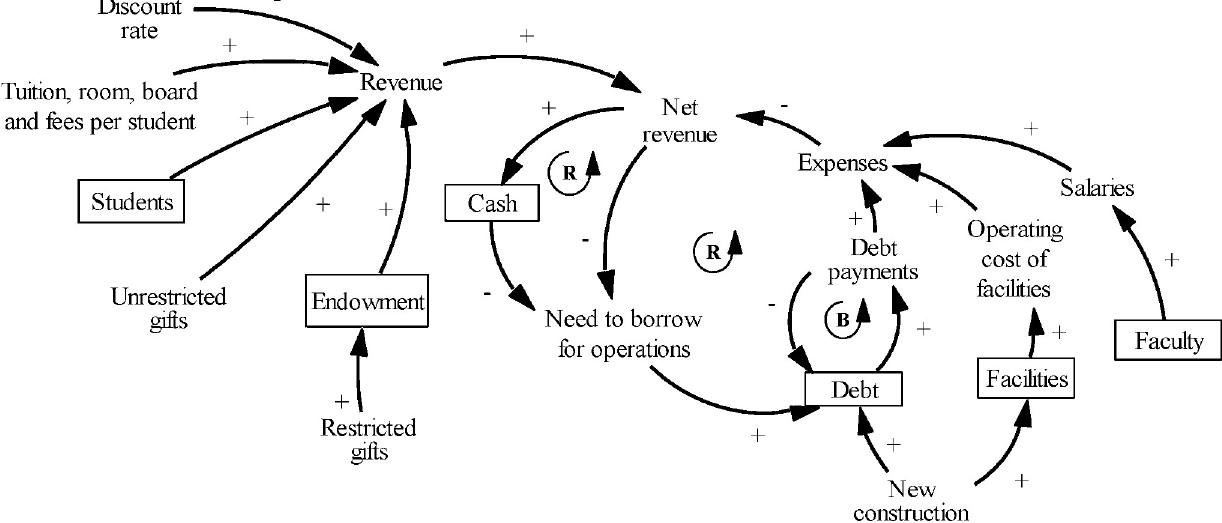
Fig 5. Causal structure of the financial